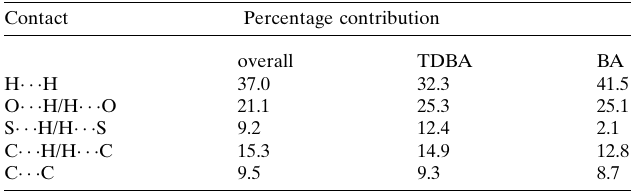
Table 3 Percentage contributions of selected interatomic contacts to the Hirshfeld surface for (I) and for the the individual TDBA and BA molecules.